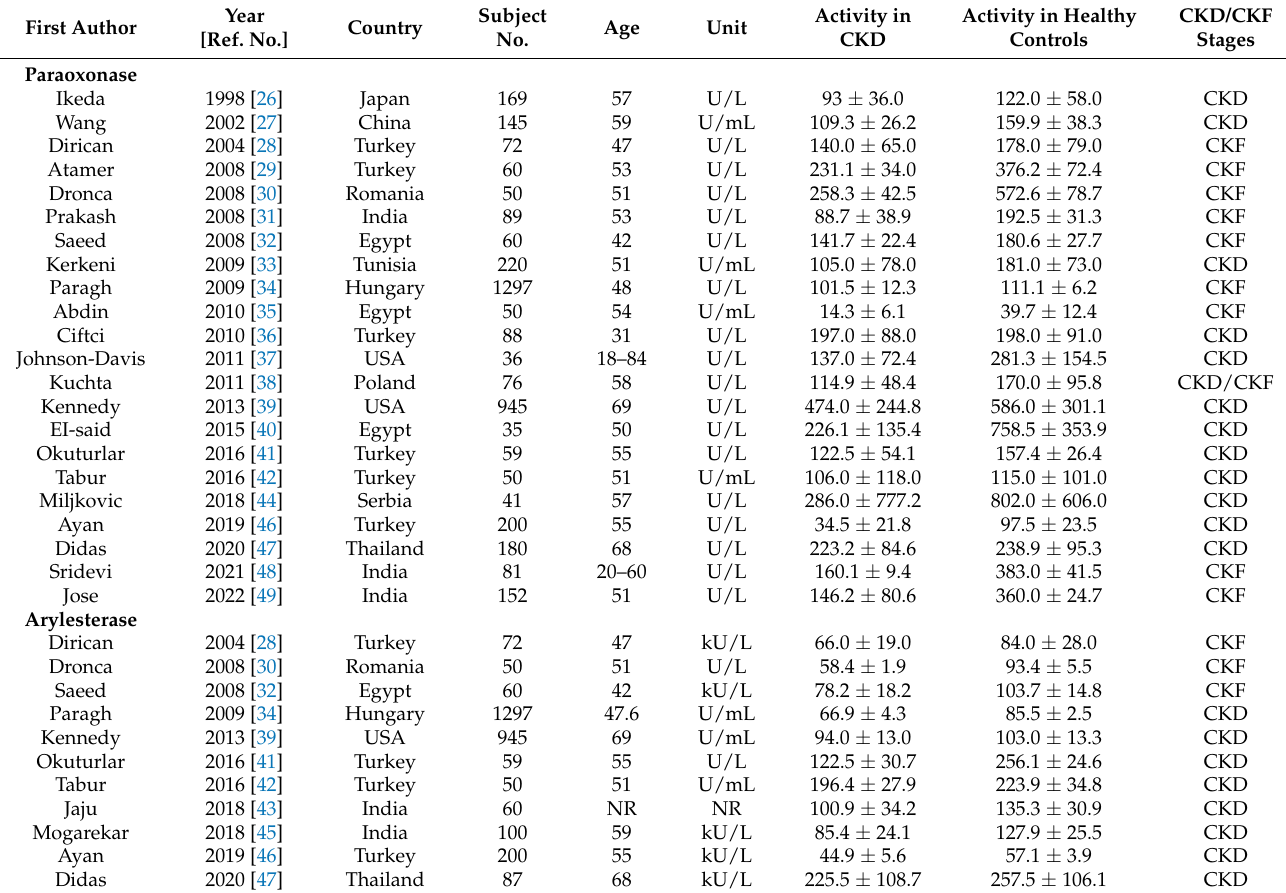
Table 1. Summary of the included articles on PON1 activities in patients with CKD.